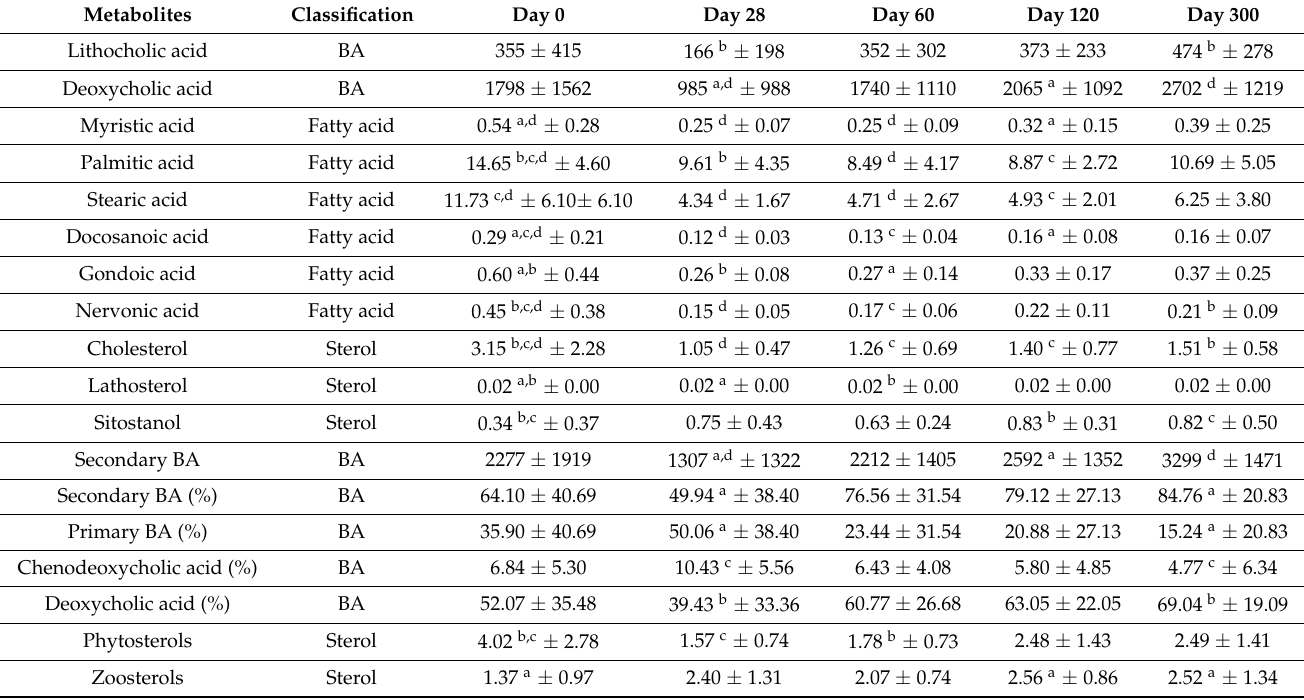
Table 7. Concentrations of fecal metabolites that significantly differed over time within DOX